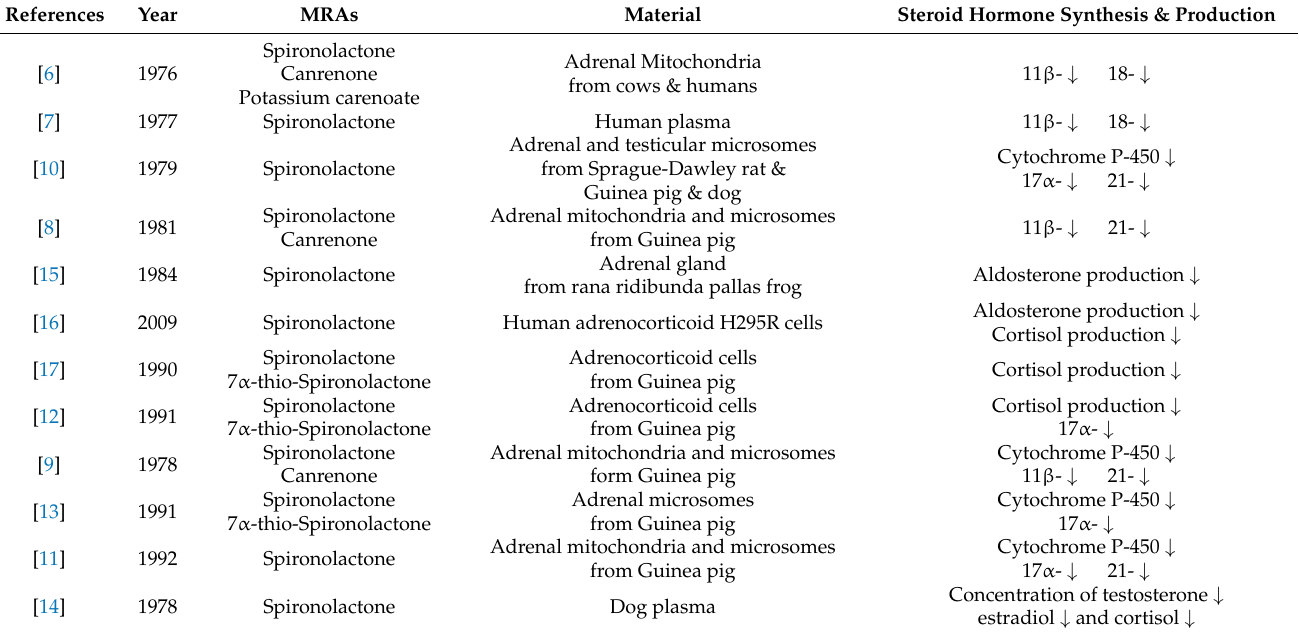
Table 1. Comparison of steroid hormone synthesis inhibition by